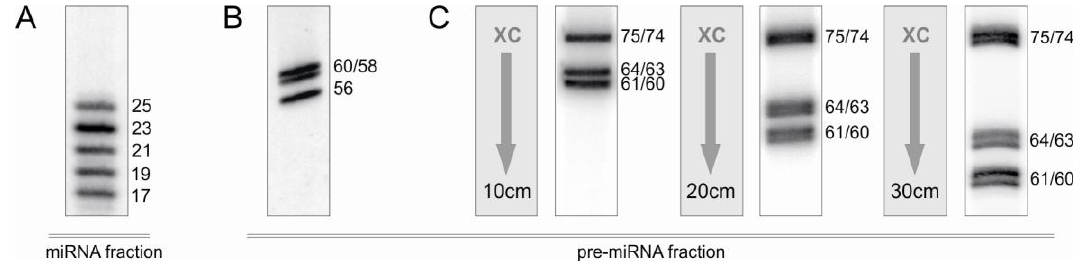
FIGURE 2. Electrophoretic separation of miRNAs and pre-miRNAs. (A) Resolution required for miRNA analyses. End-labeled, synthetic ORNs (17–25 nt) were run as a marker on 12% PAA until the xylene cyanol dye (XC) reached a distance of 10 cm. (B and C) The resolution required for pre-miRNA analyses. Labeled ORNs of ~60–70 nt, as indicated in the figure, were run for 10-, 20-, and 30-cm distances. Sequences of all ORNs are listed in a supplementary table (Table